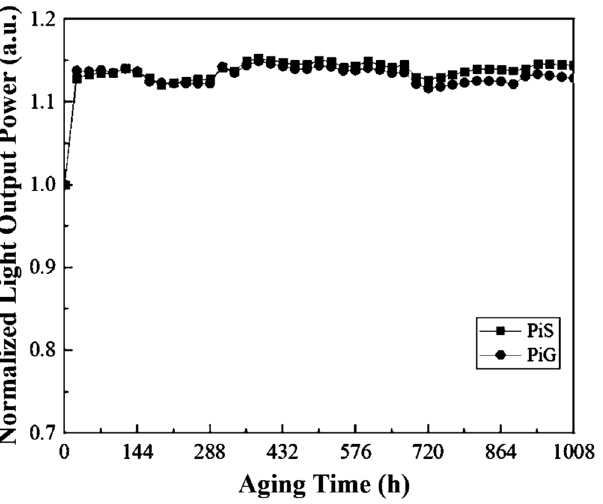
Figure 4. Normalized light output flux drift of PiS WLED and PiG WLED at 350 mA for 1008 h.